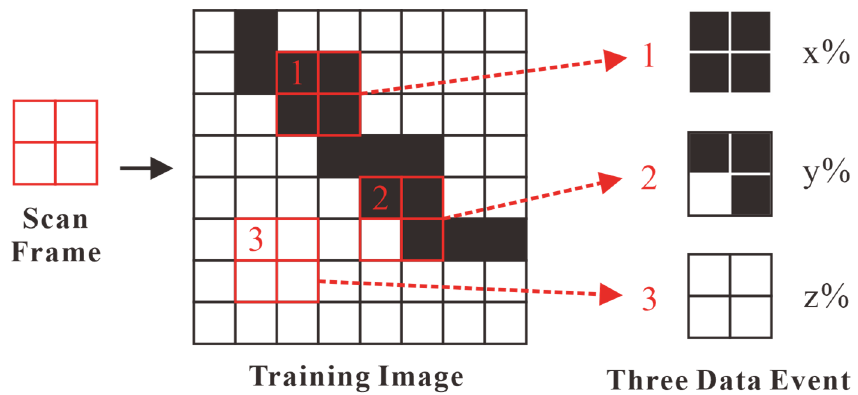
Figure 5. Construction of multi-point geostatistical data template.